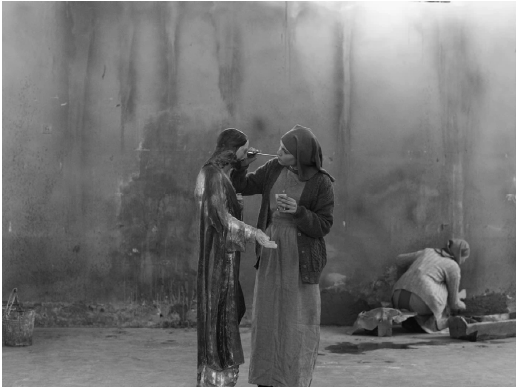
Figure 4 . Ida stands eye ‐ to ‐ eye with Jesus. Figure 4. Ida stands eye-to-eye with Jesus.